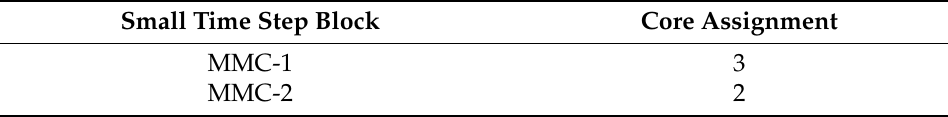
Table 2. Core assignment of MMC models in